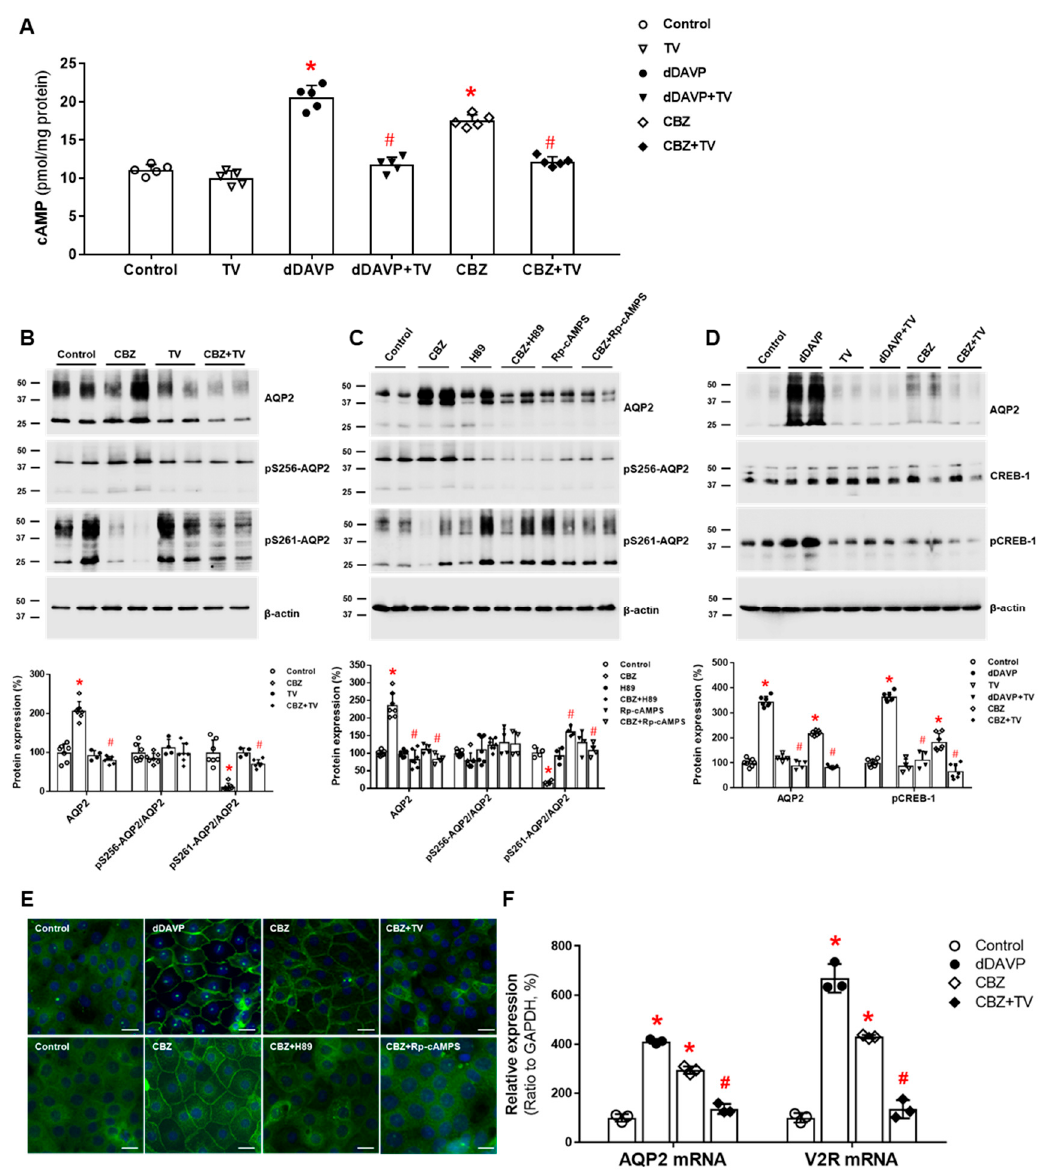
Figure 4. In vitro action of carbamazepine for aquaporin-2 (AQP2) upregulation in inner medullary collecting duct (IMCD) cells . ( A ) cAMP production was measured by ELISA in IMCD suspensions after treatment with vehicle (control), 100 nM tolvaptan (TV), 10 nM 1-desamino-8-D-arginine vasopressin (dDAVP), or 100 µM carbamazepine (CBZ) at 37 °C for 30 min. ( B ) Immunoblot analyses of total AQP2, pSer256-AQP2, and pSer261-AQP2 in primary cultured IMCD cells treated with 100 µM CBZ with and without 100 nM tolvaptan (TV) for 30 min. ( C ) Immunoblot analyses of total AQP2, pSer256-AQP2, and pSer261-AQP2 in primary cultured IMCD cells treated with 100 µM CBZ with and without a PKA inhibitor H89 or Rp-cAMPS. ( D ) Immunoblot analyses of total AQP2, total CREB, and pCREB-1 in primary cultured IMCD cells treated with 10 nM dDAVP and 100 µM CBZ with and without 100 nM TV. ( E ) Immunofluorescence microscopy for AQP2 in primary cultured IMCD cells shows that AQP2 trafficking was induced by dDAVP and CBZ but attenuated by coadministration of TV or a PKA inhibitor. ( F ) Quantitative polymerase chain reaction data show that AQP2 and vasopressin-2 receptor (V2R) mRNA expression were increased by dDAVP and CBZ but reversed by TV cotreatment. Each bar represents mean ± SD. * p < 0.05 vs. control; # p < 0.05 vs. CBZ alone by the Mann–Whitney U-test. Adapted from Ref. [38] with permission.